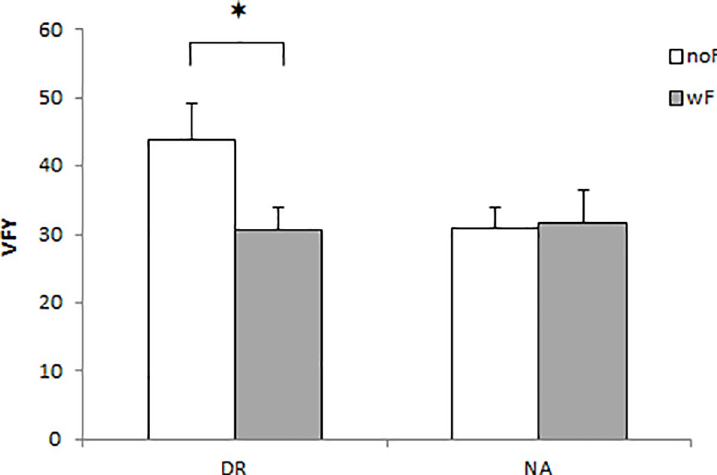
Fig 3. VFY in the AP dynamic balance with (wF) and without foam (noF) for DR and NA groups. Data are presented as mean and standard error ( � p <